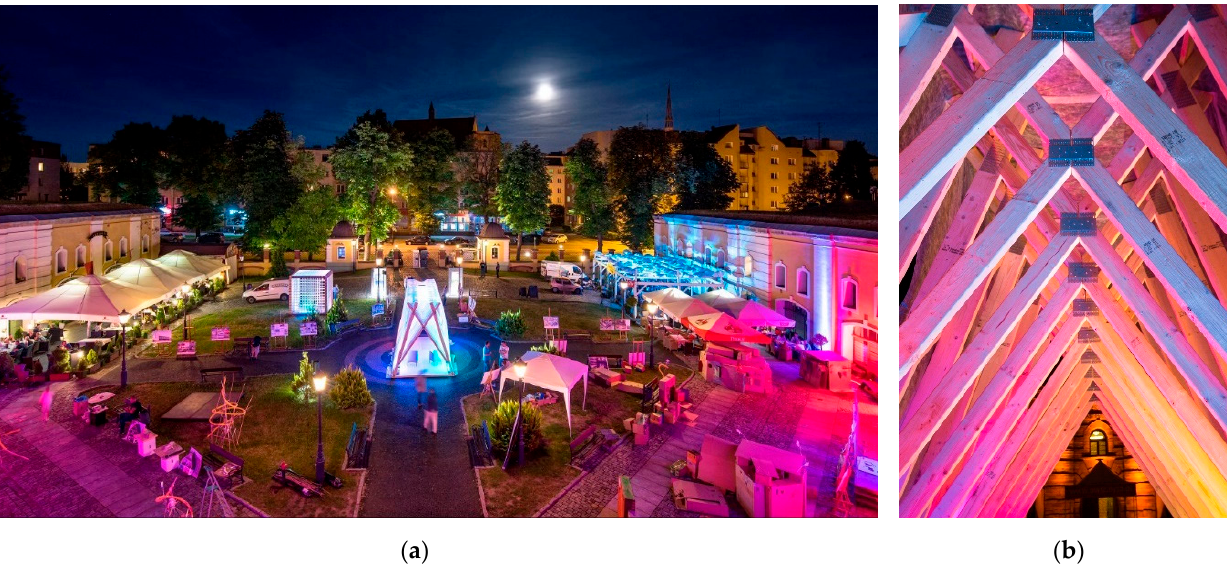
Figure 5. The Architectonic Sculpture Pavilion, 2017: ( a ) view at the Pavilion erected in Nysa, photo by Maciej Zych Photography; ( b ) detailed view of the pavilion, reproduced with permission from the Chamber of Polish Architects branch in Opole.